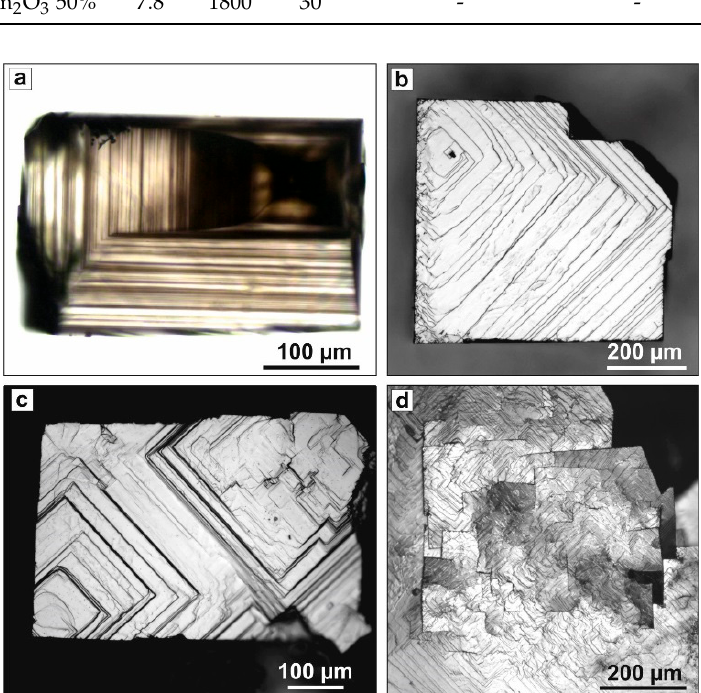
Figure 1. Optical micrographs of surface microrelief and internal structure of diamond crystals produced in the Mg-R 2 O 3 -C systems: ( a ) zoning along the {100} face (transmitted light, run R-3); ( b ) stepped {100} face with a single growth center (run R-3); ( c ) clusters of macrosteps trains from several growth centers (run R-9); and ( d ) block structure of the {100} face (run R-6).